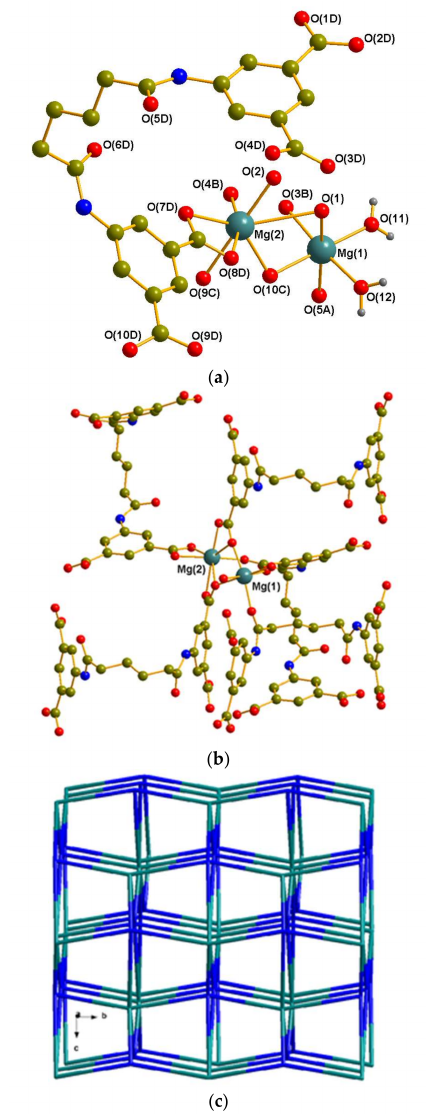
Figure 1. ( a ) Coordination environment of 1 ; Symmetry Code: (A) − x + 3/2, y + 1/2, z + 1 − y + 1, z + 1/2, (C) x, y + 1, z, (D) − x + 1, − y + 1, z − 1 a 5-connected node; ( c ) A 3D (4 4 .6 6 )- pcu-5-Pmna topological net of 1